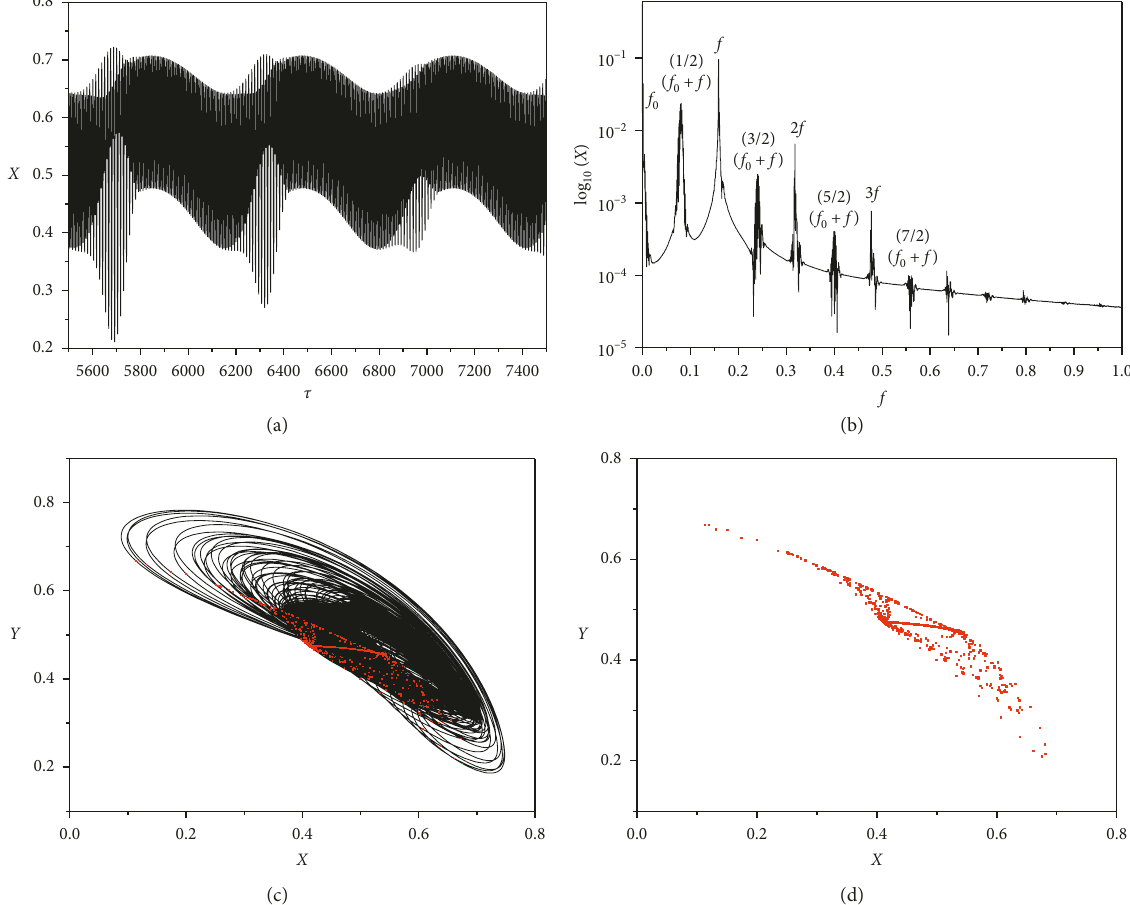
0 (cid:31) 2.12, η (cid:31) 100.58, and A 0 (cid:31) Ω